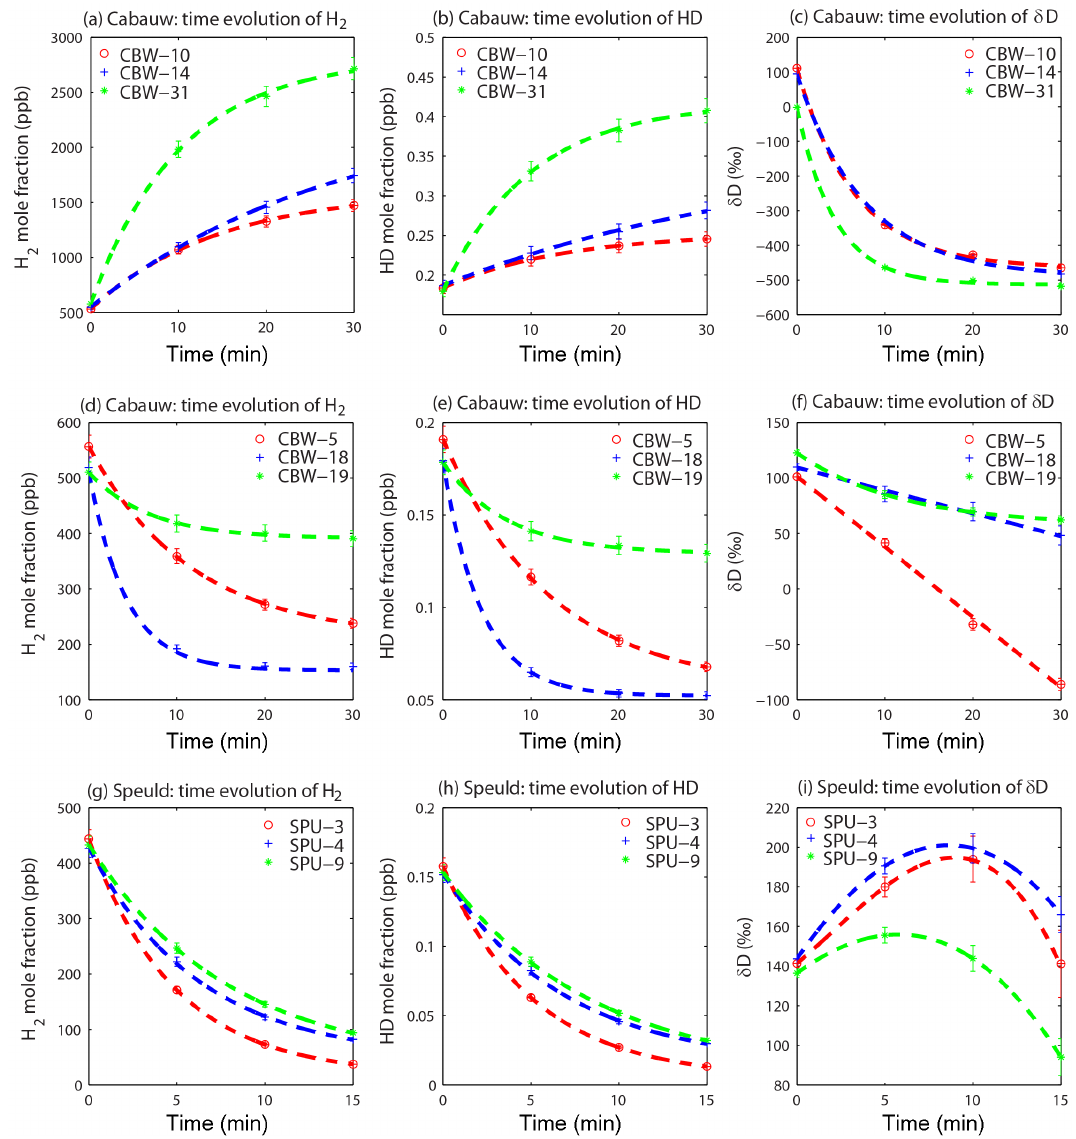
Figure 6. Time evolution of H 2 , HD and δ D in Cabauw (upper and middle panels) and in Speuld (lower panel) for representative experiments. HD is calculated from H 2 and δ D. The H 2 data are fitted with an exponential function of the form c = (cid:0) c 1 − c e , app (cid:1) e − k app t + c e , app , where c 1 and c e , app are the H 2 mole fractions initially and in equilibrium, and k app is the apparent soil uptake rate constant for H 2 . A similar exponential function is applied to the HD data. Error estimates for H 2 , HD and δ D are shown. The connecting lines for δ D data are included to guide the